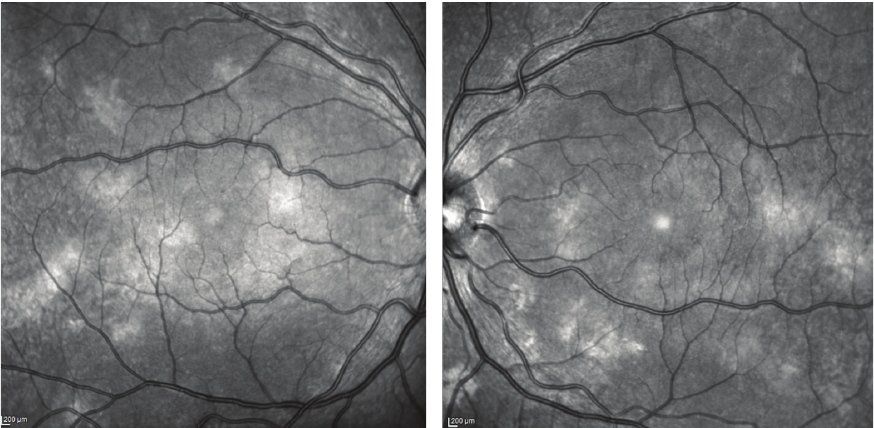
Figure 4: Near infrared reflectance showing choroidal alterations in neurofibromatosis type 1. The typical rounded or patchy alterations are clearly shown.